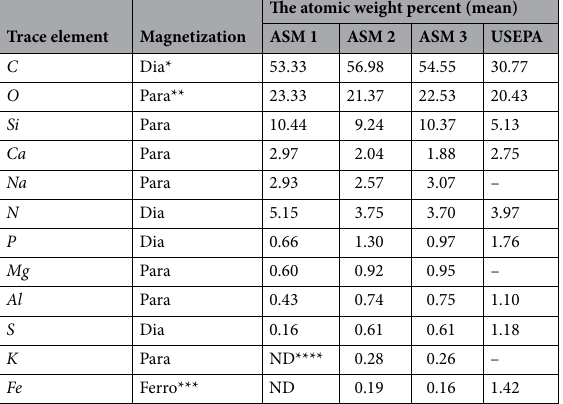
Table 8. The mean atomic weight percent of trace elements in the dried sludge. *Dia = diamagnetic. **Para = paramagnetic. ***Ferro = ferromagnetic. ****N.D =